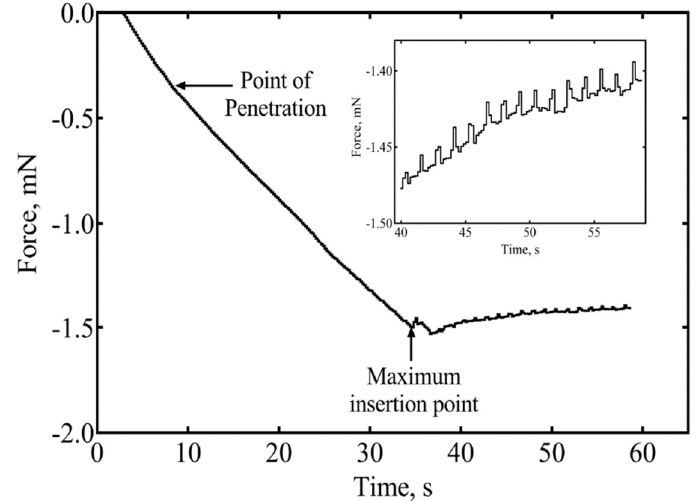
Figure 6. Buckling test. Force measured when a single shank a-SiC probe is lowered against a glass surface ( a ). An image of the buckled state of a 2 mm long shank ( b ) and a COMSOL prediction of the buckled state ( c ).